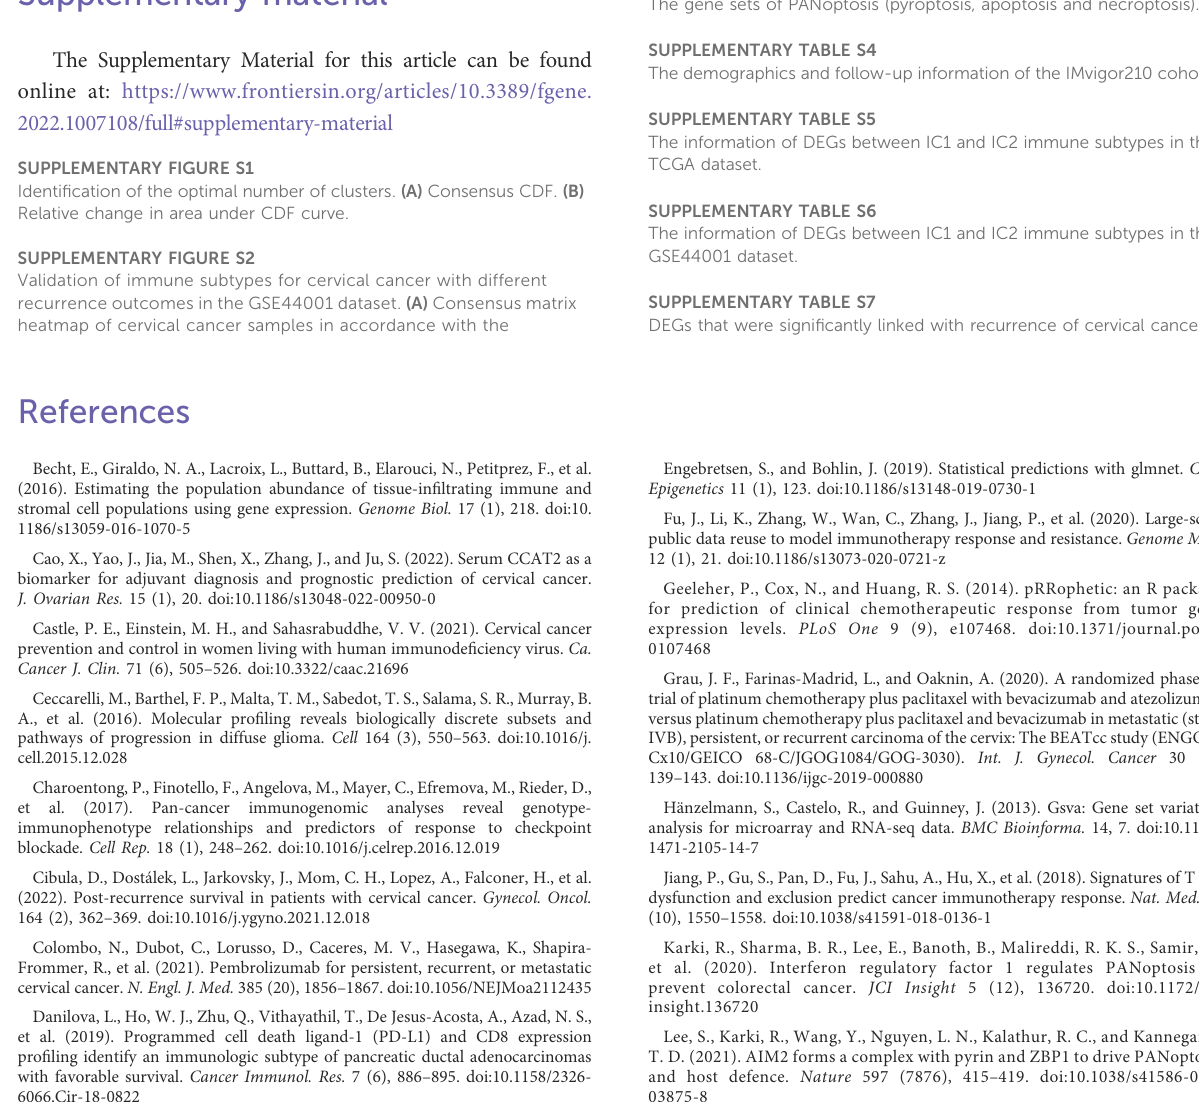
SUPPLEMENTARY TABLE S1 The demographics and follow-up data of cervical cancer samples in the TCGA and GSE44001 datasets. SUPPLEMENTARY TABLE S2 The list of 782 immune-related genes.